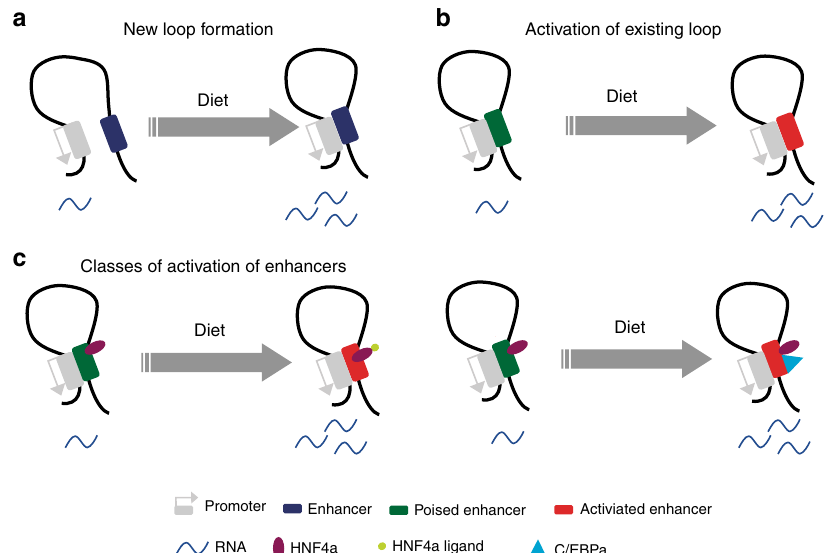
Fig. 8 Promoter/enhancer interactions during metabolic adaptation to diet. a , b Diet-induced differential gene expressions involves two types of promoter – enhancer interactions: de novo formation of promoter – enhancer interactions ( a ); activation of preformed promoter – enhancer interactions ( b ). c Enhancer activation can occur through multiple mechanisms. Nuclear receptors, including Hnf4 α , can be activated by ligand binding, leading to local increases in histone acetylation and enhancer function (left panel). Alternatively, lineage-specifying transcription factors, including HNF4 α , can bind constitutively at signal responsive enhancers and co-bind with other transcription factors, such as C/EBP α to regulate metabolism-related genes (right